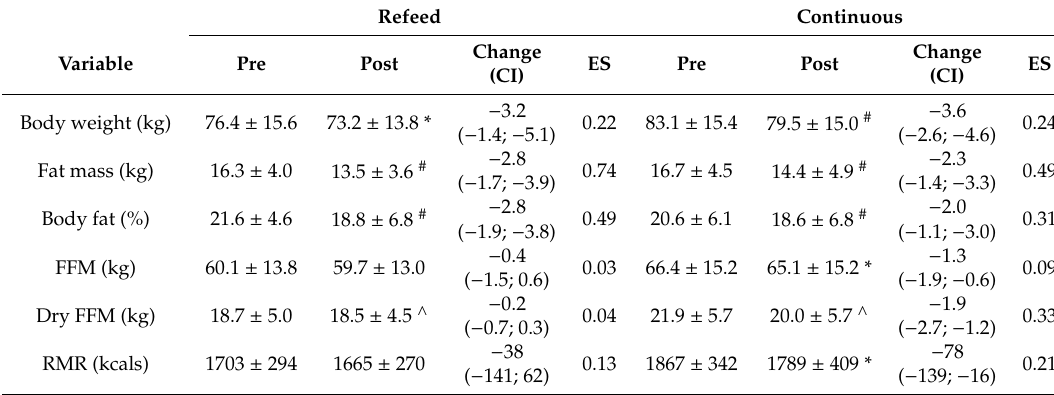
Table 3. Body composition and resting metabolic rate (mean ± SD).